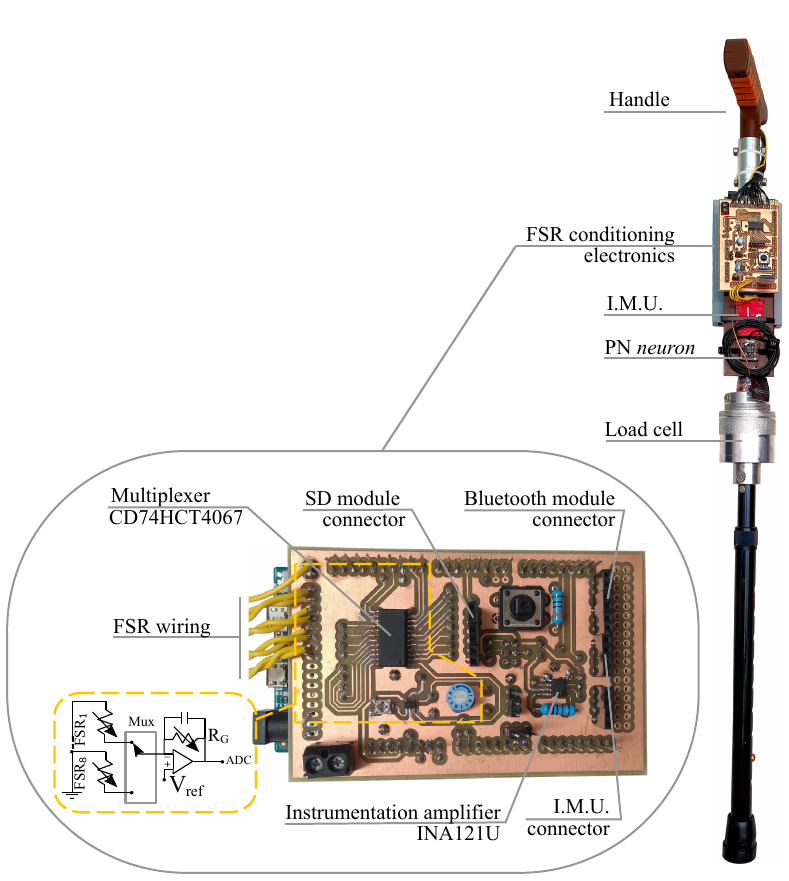
Figure 6. Instrumented cane and detail of the custom shield.